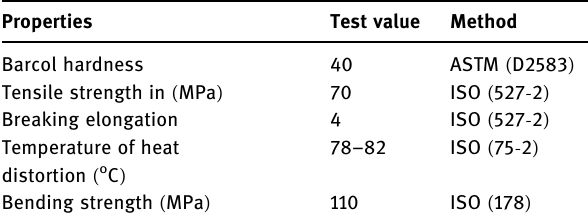
Table 1: Clear cured casting mechanical properties for UP Properties